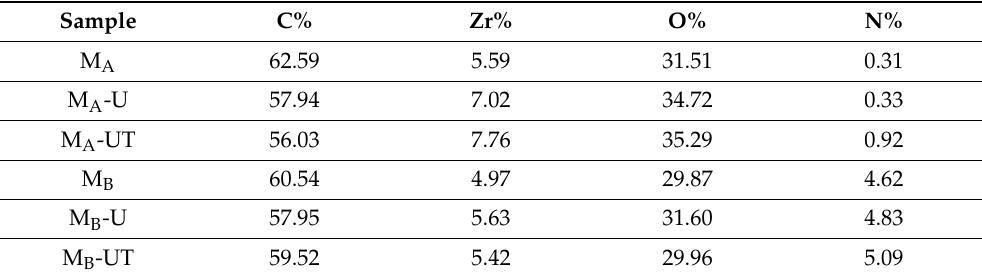
Table 2. Surface chemical composition (in atomic concentration %) of the studied catalysts determined by